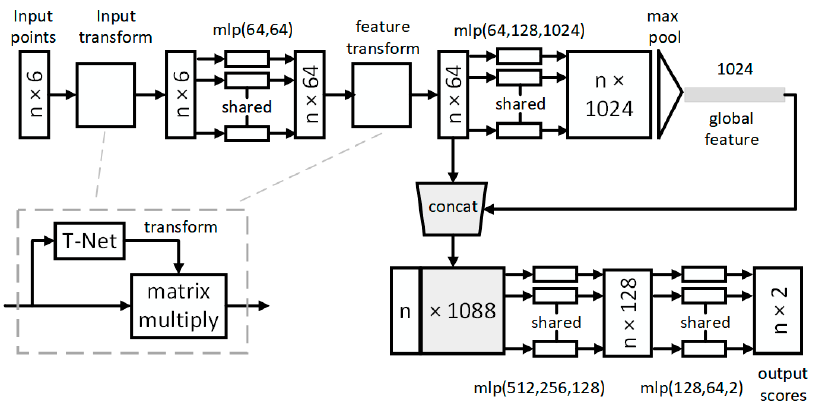
Figure 12. Network structure of PointNet.